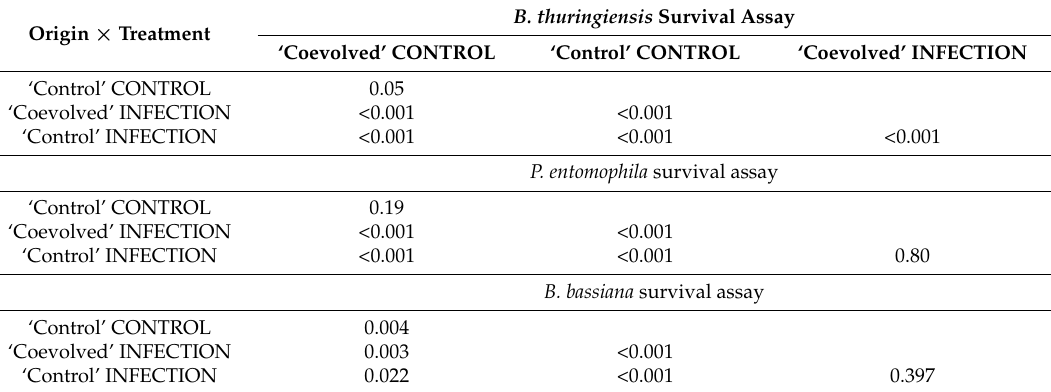
Table 1. Results ( p -values) of pairwise-wise comparison of survival curves using log-rank tests followed by Holm